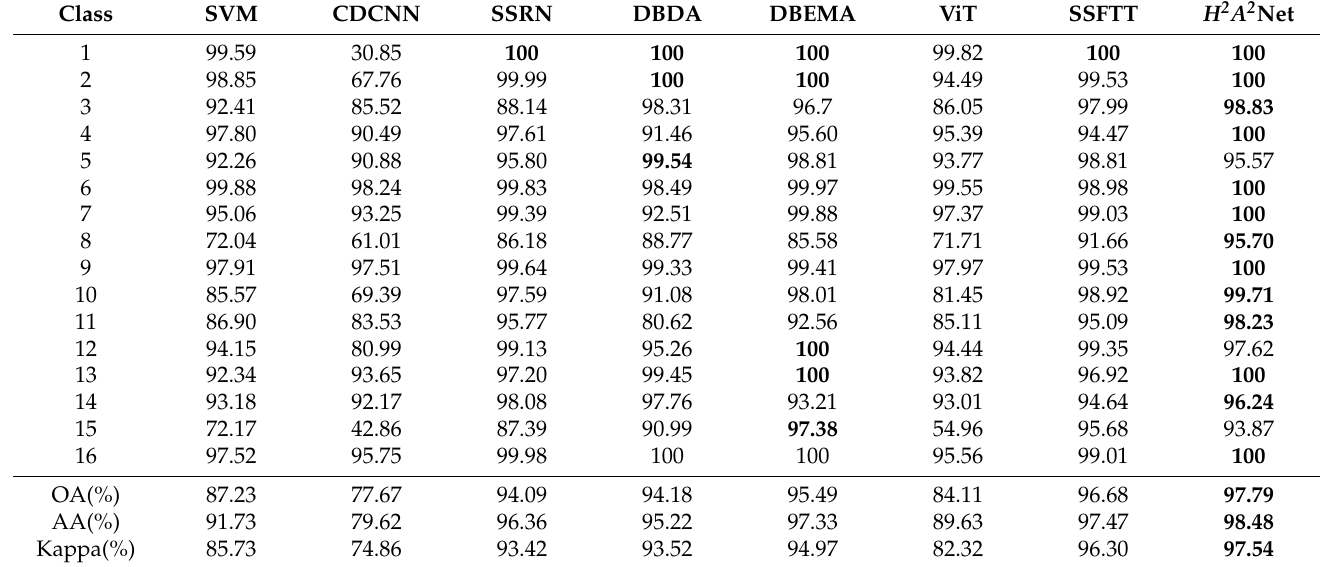
Table 5. The classification accuracy for the UP dataset based on 0.5% training samples. Table 6. The classification accuracy for the SV dataset based on 0.5% training samples.